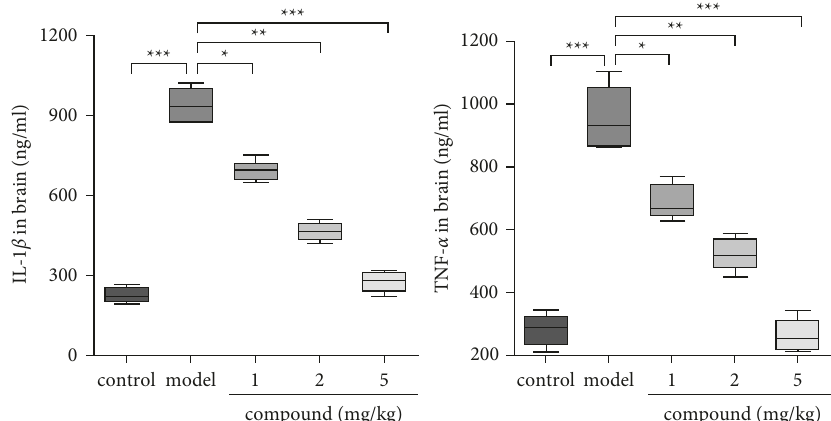
Figure 5: Markedly decreased inflammatory cytokines releasing into brain after treating by the above compound. The drug-resistant Gram- negative bacteria were used to induce the ventriculitis on the animal; next, the compound was employed for implementing the treatment at specific concentration. The inflammatory cytokines releasing into the brain was tested utilizing ELISA detection. Control refers to the normal animal, and the model refers to the animal with ventriculitis. 1, 2, and 5 refers to the animal treated with the indicated compound.